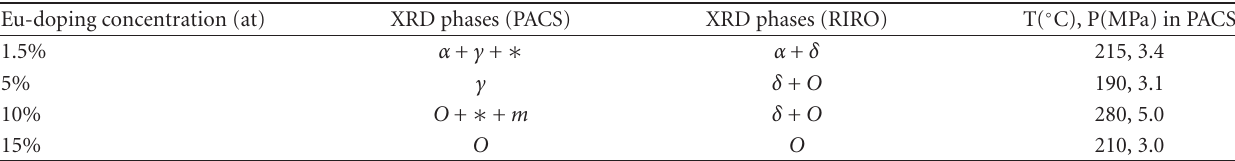
Table 1: Summary of crystalline phases obtained in both stages. Stage 1: PACS method. Stage 2: RIRO technique at 1100 ◦ C. The third column shows the pressure and reaction temperature parameters observed in PACS.